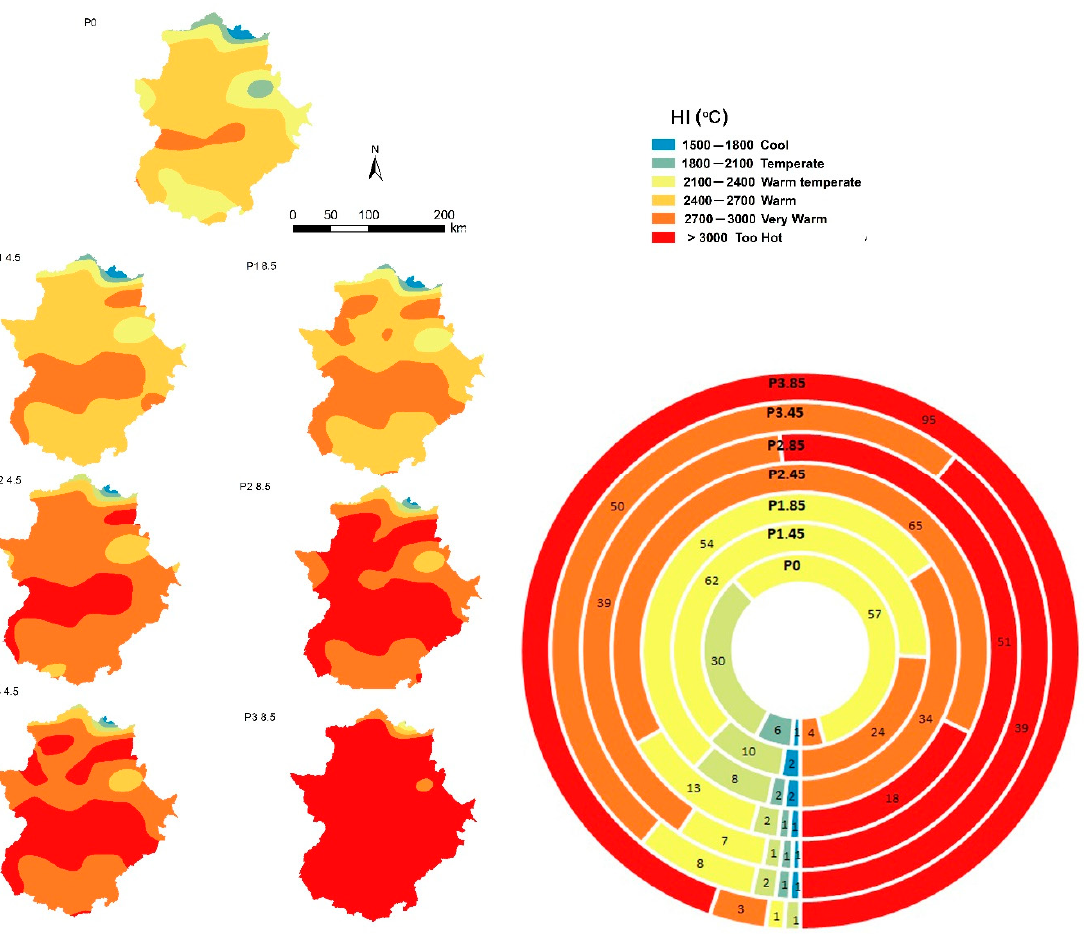
Figure 6. Spatial distributions of HI during the historical period (P0) and the future time periods (P1, P2 and P3) in Extremadura. The percentages of each HI class for all time periods and under both scenarios, RCP 4.5 and RCP 8.5, are also shown (for instance, P1.45 means the time period P1 under the scenario RCP 4.5).